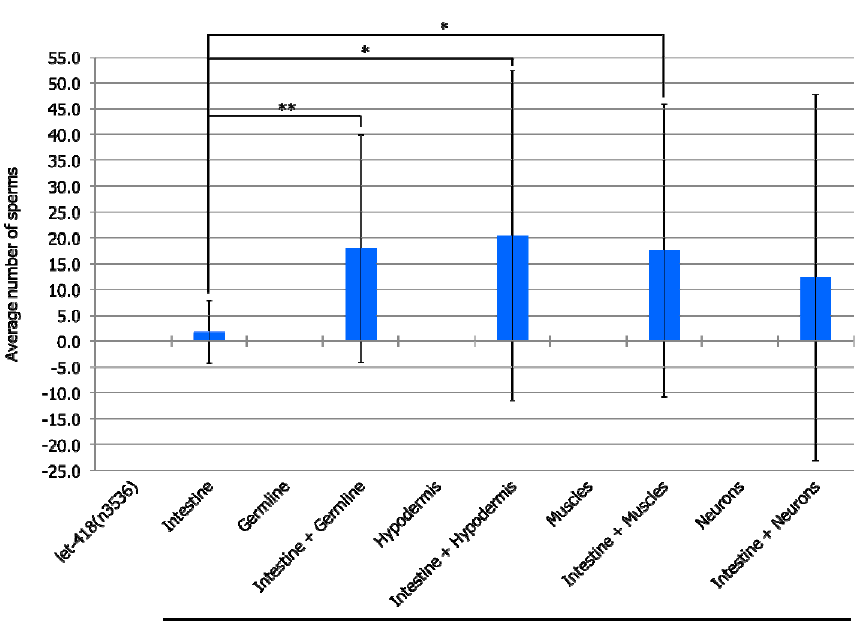
Figure 6. LET-418 is required in multiple tissues during germline development. ( A ) The percentage of worms with sperms after 75 h after birth. Error bars indicate standard deviation. * p < 0.05; ** p ≤ 0.01; *** p < 0.001; Fisher’s test. ( B ) The average number of sperms 75 h after birth. For clarity purpose we omitted the strain expressing let-418 in all tissues. Error bars indicate standard deviation. * p < 0.05; ** p ≤ 0.01; *** p < 0.001; unpaired t -test.